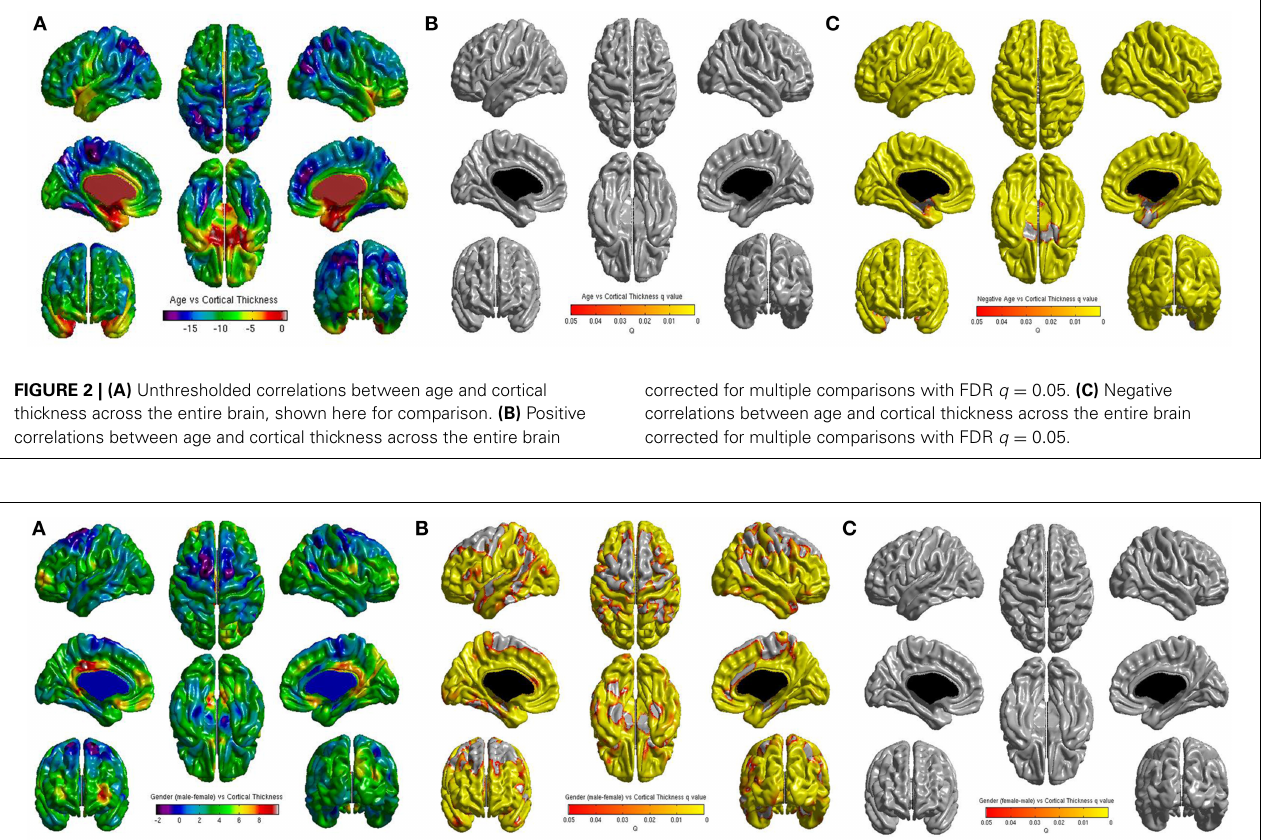
(C) Negativecorrelations(female—male)betweengenderandcorticalthickness across the entire brain corrected for multiple comparisons with FDR q = 0 . 05